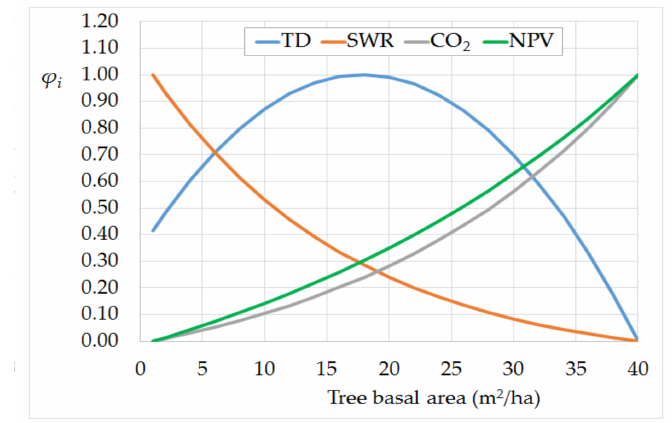
Figure 4. Normalized values of the objectives tree diversity (TD), surface water runoff (SWR), carbon content (CO 2 ), and net present value (NPV) according to the equations in Table 2.